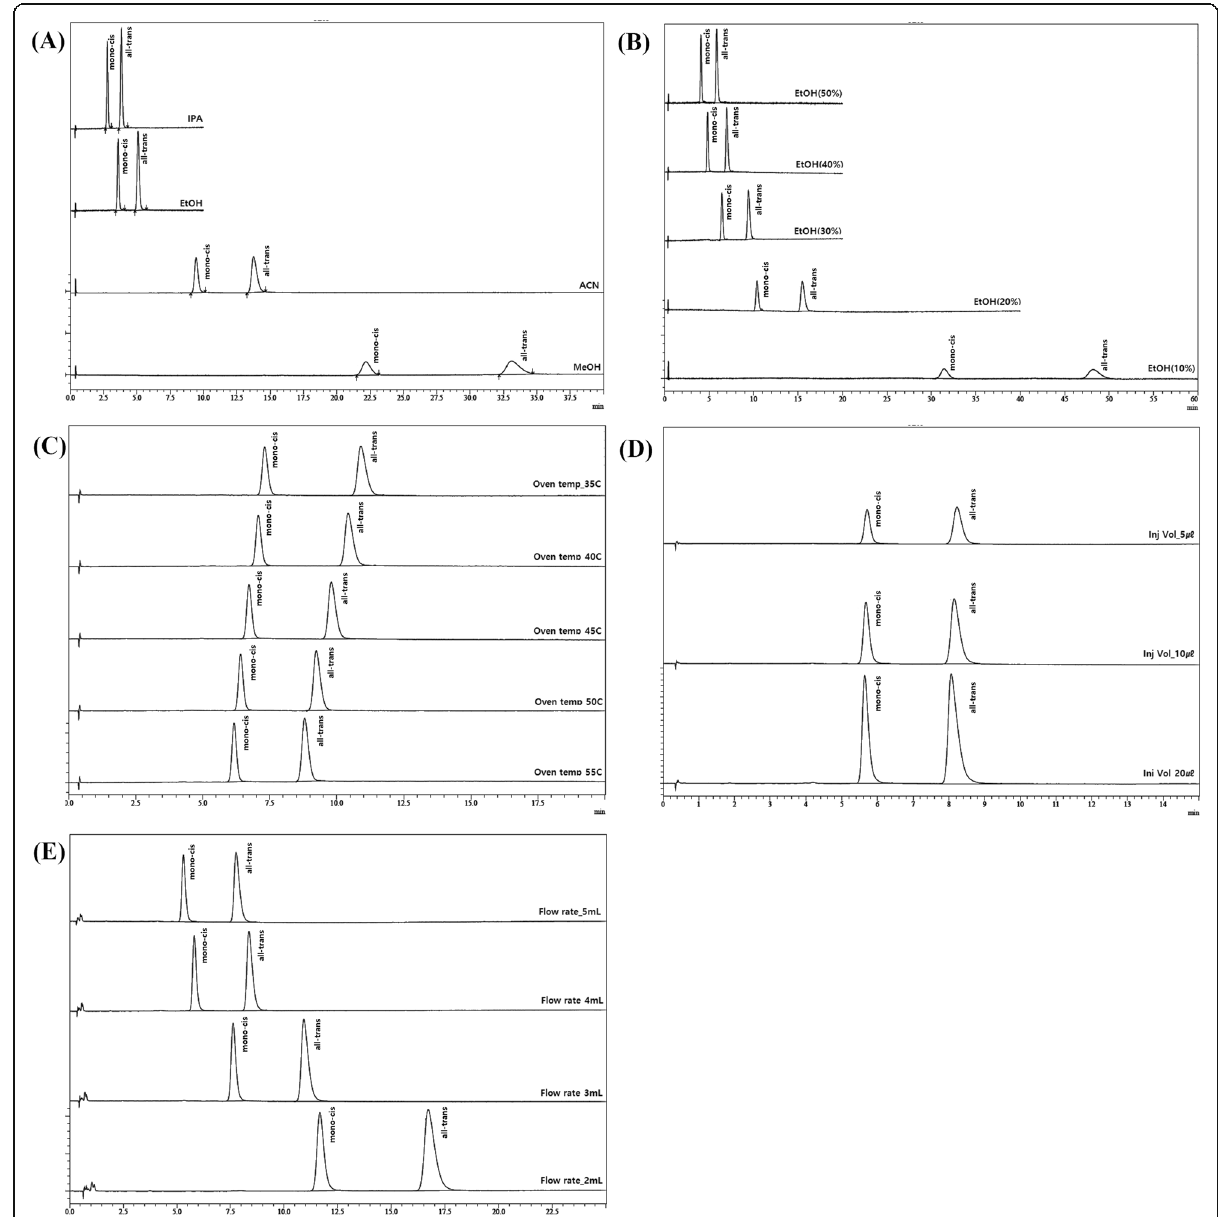
Fig. 3 SubFC/PDA chromatograms obtained during the optimization of chromatographic conditions: ( A ) organic modifier type, ( B ) organic modifier content in mobile phase, ( C ) column temperature, ( D ) injection volume, and ( E ) flow